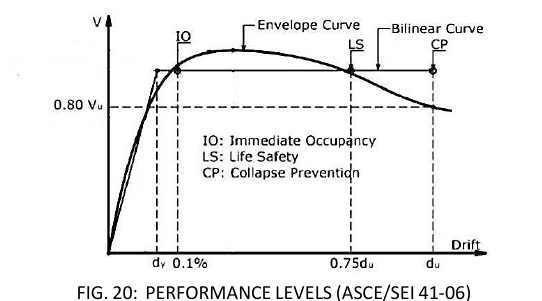
FIG. 19 BILINEAR IDEALIZATION OF FRAME-2 TABLE3: FRAME-2 SEISMIC PARAMETERS BEFORE AND AFTER RETROFITTING